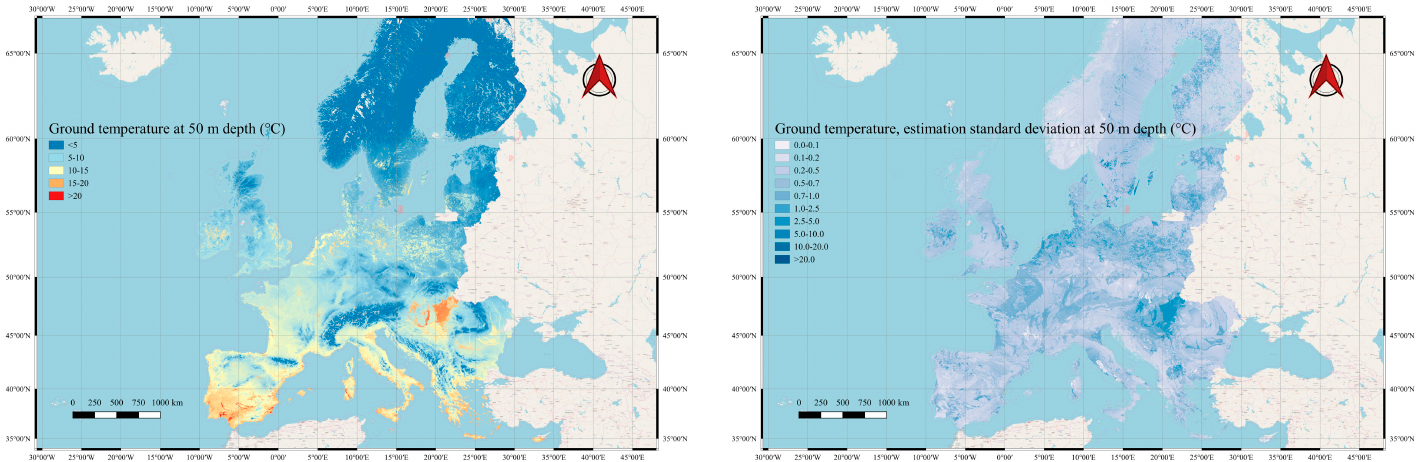
Figure 7. Estimation of average ( Left ) and standard deviation ( Right ) of ground temperature at 50 m depth in Europe.